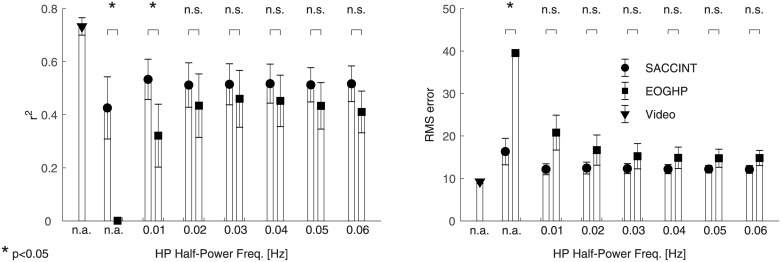
Across-subject performance of SACCINT and EOGHP.(A) The left panel shows across-subject r2 values, separately for SACCINT (circles), EOGHP (squares), and the “ideal” performance for the current set of parameters obtained from the ground truth (triangle) using the same parameters. The second and third columns show the data without HP filtering. (B) The right panel shows across-subject RMS error using the same symbols.